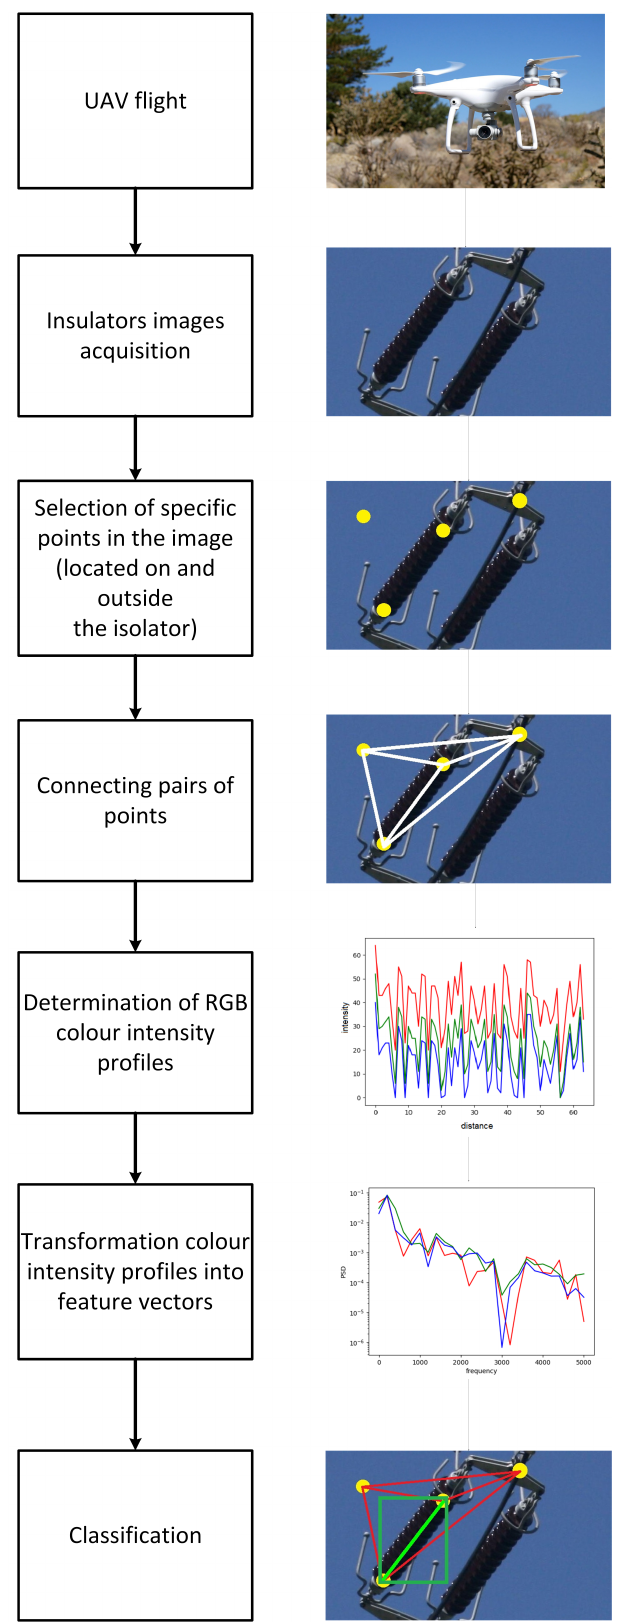
Figure 1. Consecutive steps of the proposed